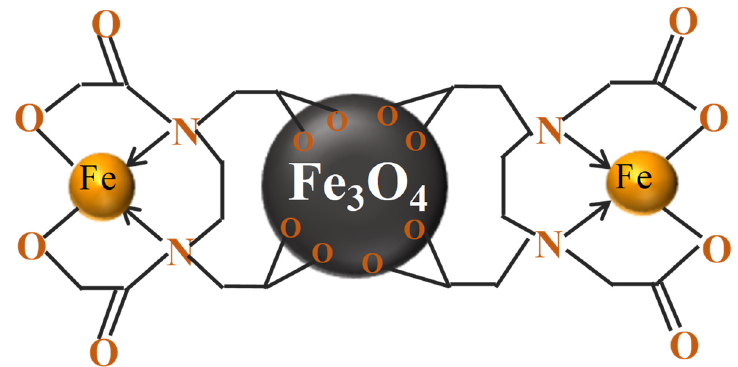
Figure 10. Proposed general structure of Fe 3 O 4 @EDTA-Fe.